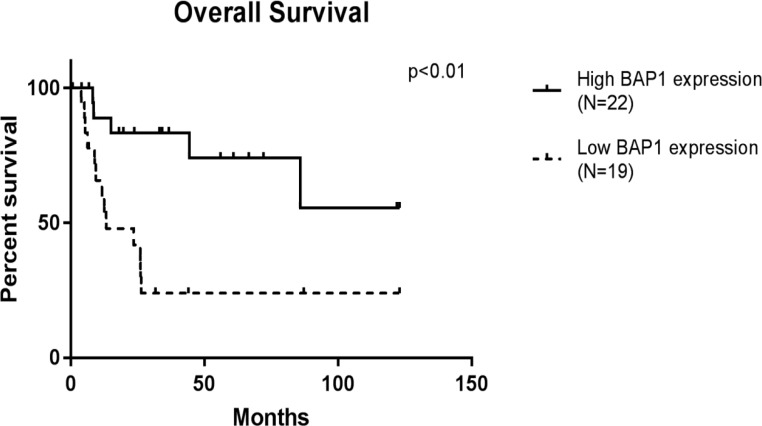
Kaplan–Meier survival analysis of BAP1 expression.Kaplan–Meier survival curves for 41 GBC cases except for in-hospital deaths and deaths from other diseases show a significantly poorer prognosis in the BAP1 low expression group.